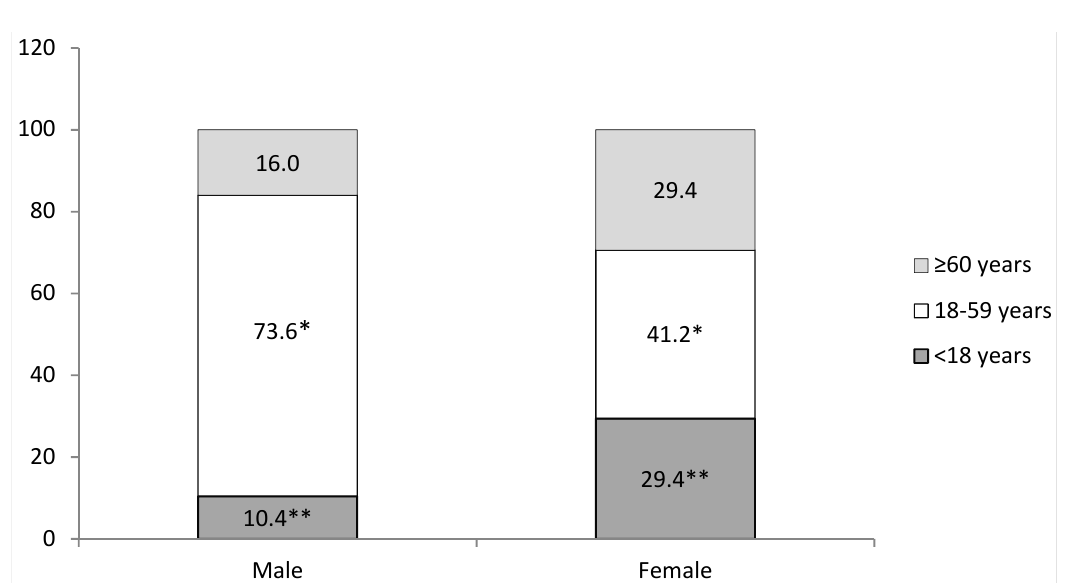
Figure 1. Distribution by age and gender (%). χ 2 = 8.275, df = 2, p = 0.016; *, ** p < 0.05. Urban residents accounted for 47.2% of the total subjects, and residents from rural areas accounted for 52.8% ( p > 0.05). Ten subjects (6.2%) admitted alcohol use before the injury.